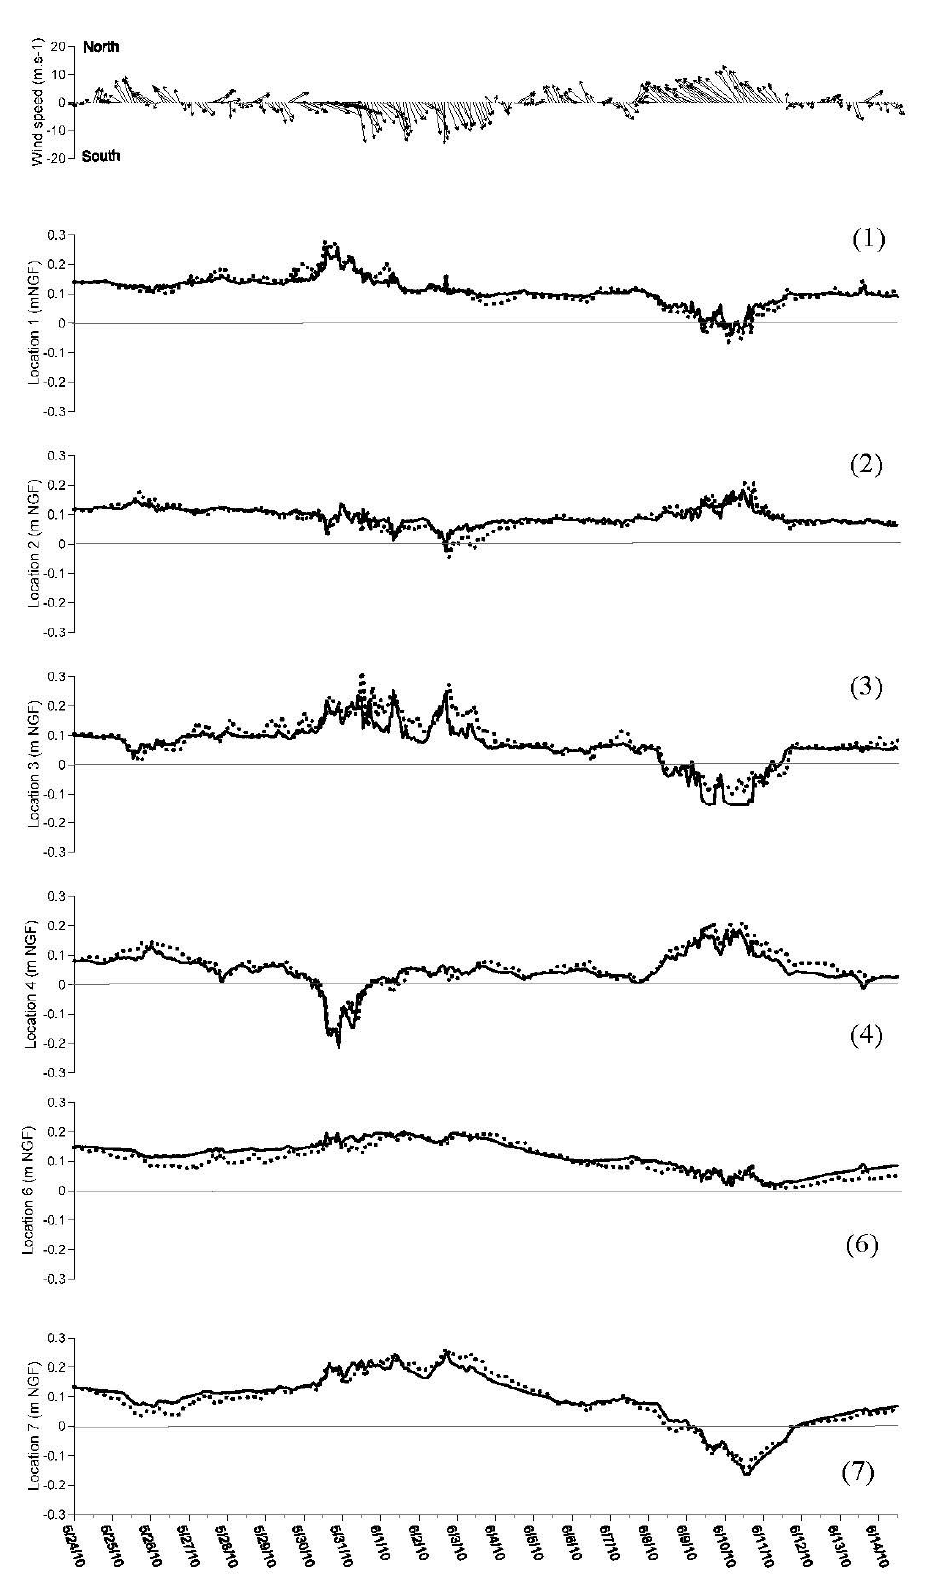
Figure 4. Measured wind vectors at the meteorological station B, measured and modeled water levels at locations 1–4, 6 and 7 (see Figure 1) from 24 May to 14 June 2010. Modeled water levels are shown with solid lines and measured water levels with dashed lines. Measured wind vectors at the meteorological station A are not represented for the sake of legibility of the